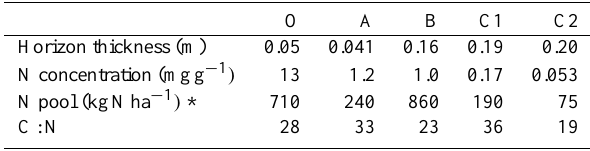
Table 3. Nitrogen concentrations, nitrogen pools and carbon-to- nitrogen ratios in different physical soil horizons (O, A, B, C1 and C2). The average depth of the mineral soil is